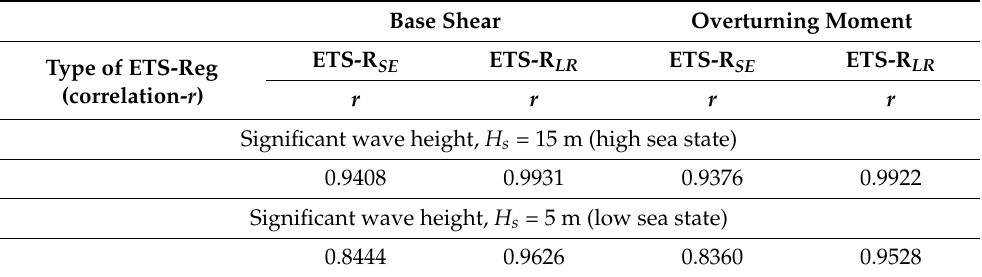
Table 1. The coefficient of correlation between two categories of ETS relationships (scatterplot) for the conditions of low and high sea states ( H s ) without current ( U = 0.0 m/s) impacts regarding the total quasi-static base shear and overturning moment